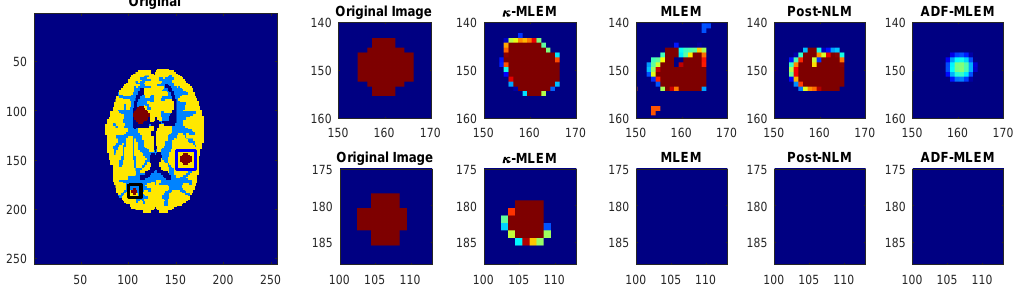
Figure 9. Zoom-in of the tumors of the Hoffman phantom reconstruction achieved with various